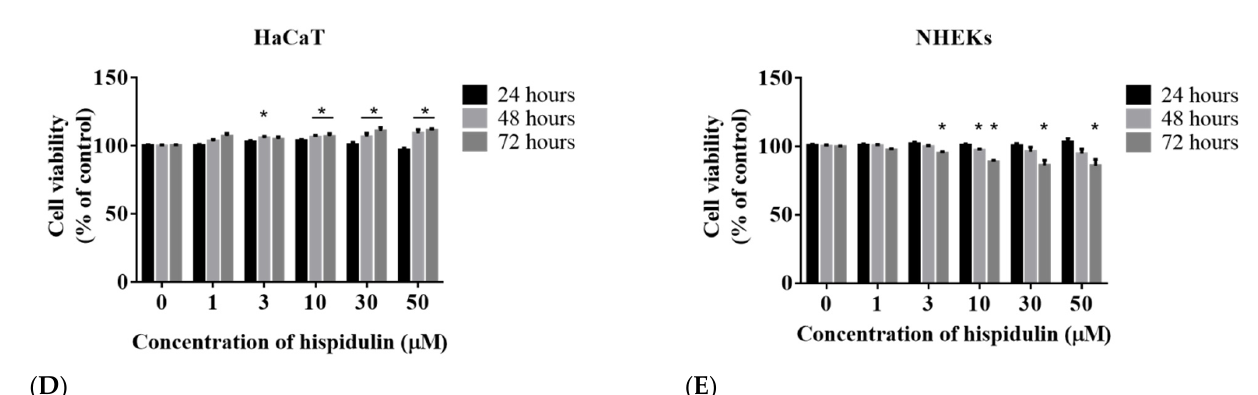
Figure 1. Cytotoxicity of hispidulin on A2058 cells, BCC cells, and keratinocytes. A2058 cells were treated with indicated concentrations (0, 1, 3, 10, 30, and 50 µM) of hispidulin for 24, 48, and 72 h, and cell survival was determined by the ( A ) MTT assay and ( B ) crystal violet assay. ( C ) BCC cells were treated with indicated concentrations (0, 10, 30, and 50 µM) of hispidulin for 24, 48, and 72 h, and cell survival was determined by the MTT assay. ( D , E ) Two kinds of keratinocytes (HaCaT and NHEKs) were treated with indicated concentrations (0, 1, 3, 10, 30, and 50 µM) of hispidulin for 24, 48, and 72 h, and cell survival were determined by the MTT assay. Data are presented as percentage of control and mean ± SE. * p < 0.05 compared with the untreated control group (n = 5).